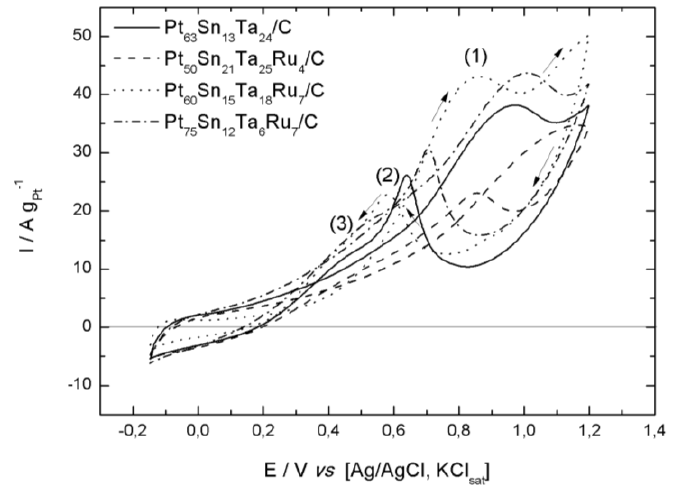
Figure 4. Cyclic voltammograms from PtSn/C catalysts modified with Ta and Ru in the presence of